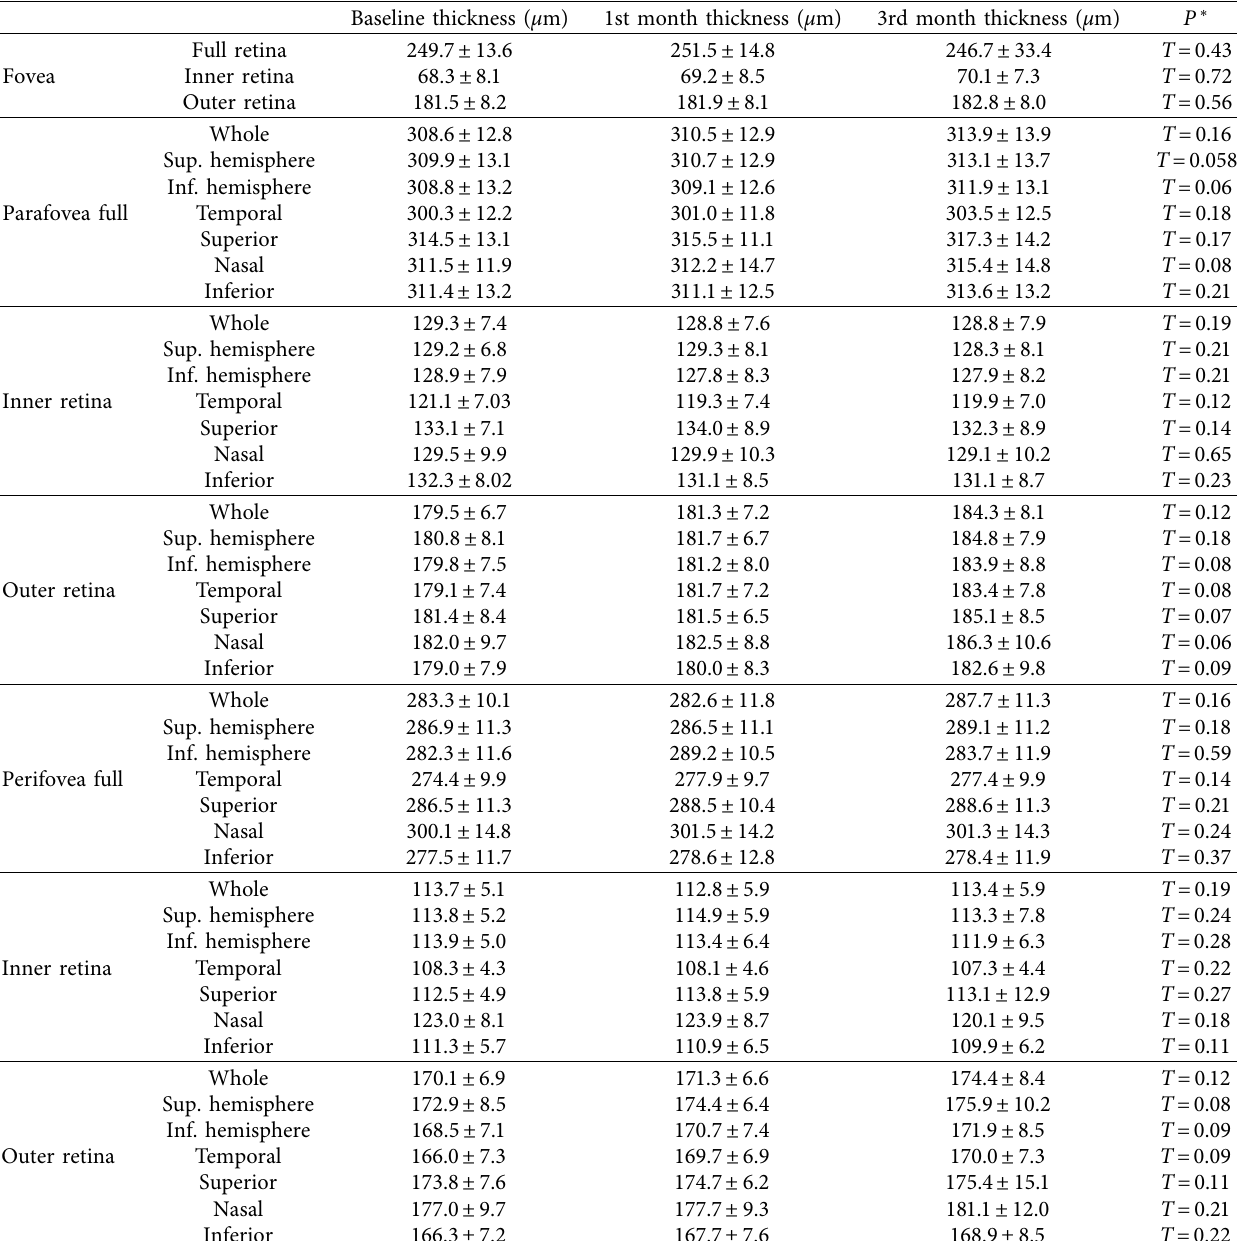
Table 1: Retinal parameter over the study